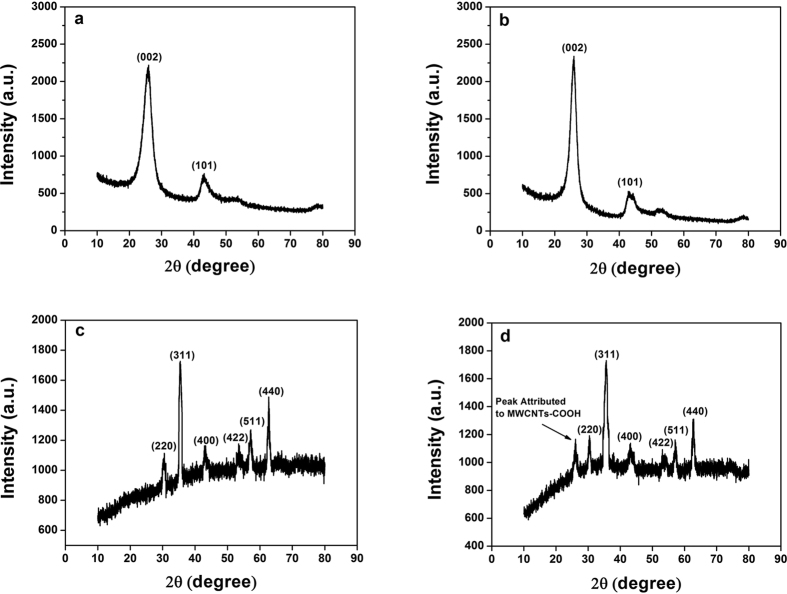
XRD patterns of (a) MWCNTs, (b) MWCNT-COOH, (c) Fe3O4 and (d) MWCNTs-Fe3O4.